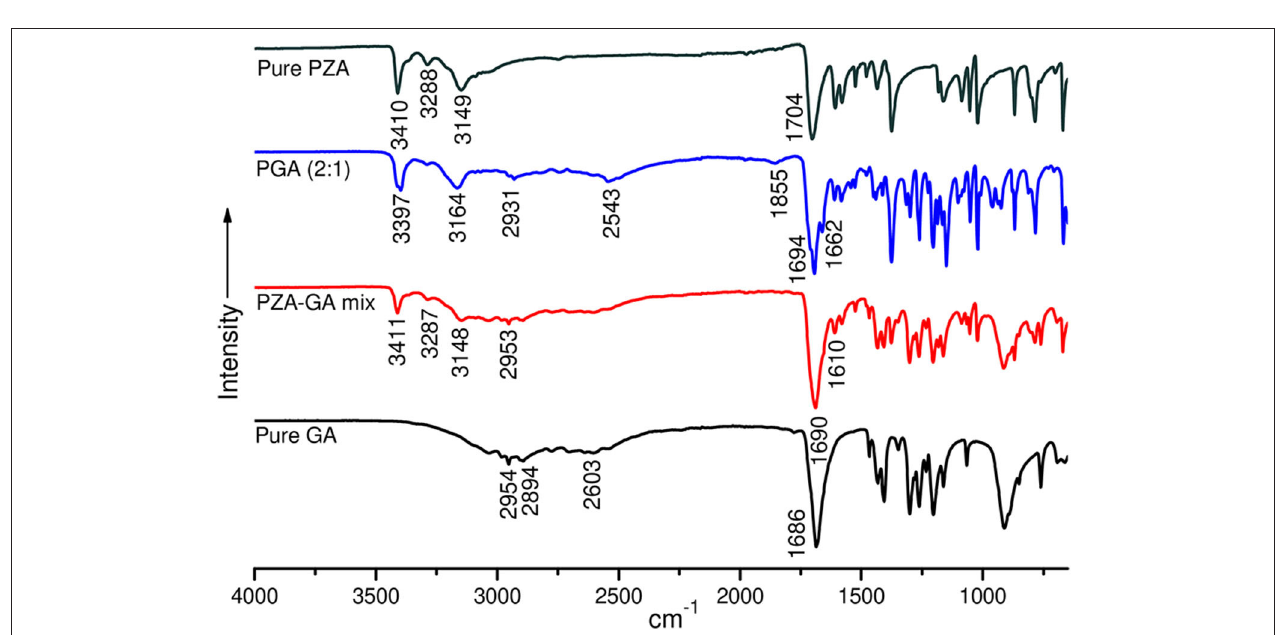
FIGURE 5 | FTIR spectra of pure pyrazinamide (PZA), PGA (2:1) co-crystal, 2:1 physical mixture, and pure pentanedioic acid (GA).